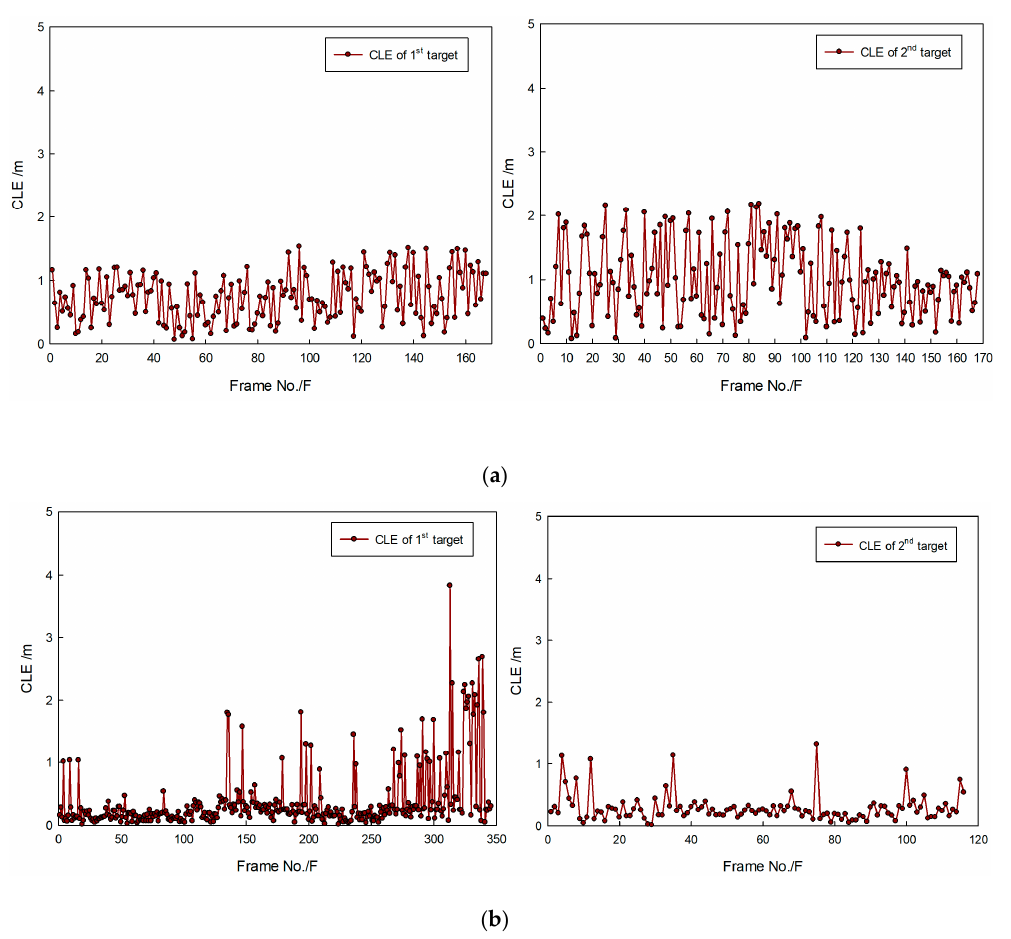
Figure 27. CLE gained by proposed method: results in ( a ) first and ( b ) second sequence of FLS